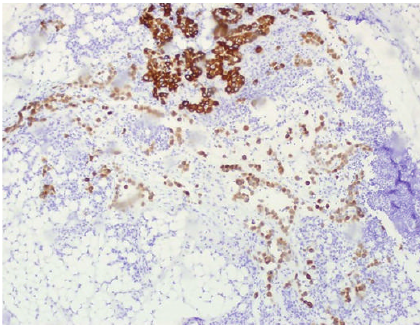
Figure 4: Immunohistochemistry showing cytokeratin-positive cells.